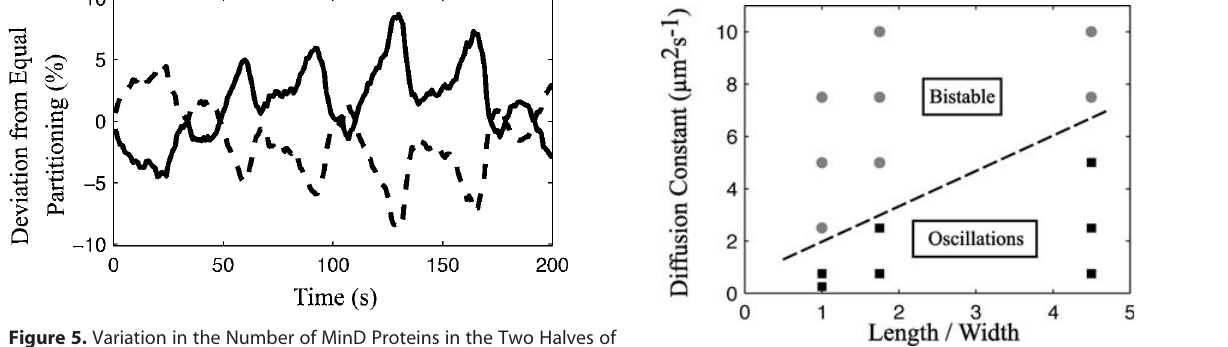
Figure 5. Variation in the Number of MinD Proteins in the Two Halves of the ftsZ (cid:1) 10- l m Cell in the Stochastic Model Percentage of deviation from equal partitioning (i.e., 50% of the total molecule number goes to each pole) of membrane-bound MinD molecules. The percentage of deviation for one half of the cell is plotted as solid black and the percentage of deviation in for other half is plotted as dashed black. DOI: 10 (cid:1) 9 cm 2 s (cid:1) 1 whereas the rod-shaped 4.5- l m wt cell is bistable